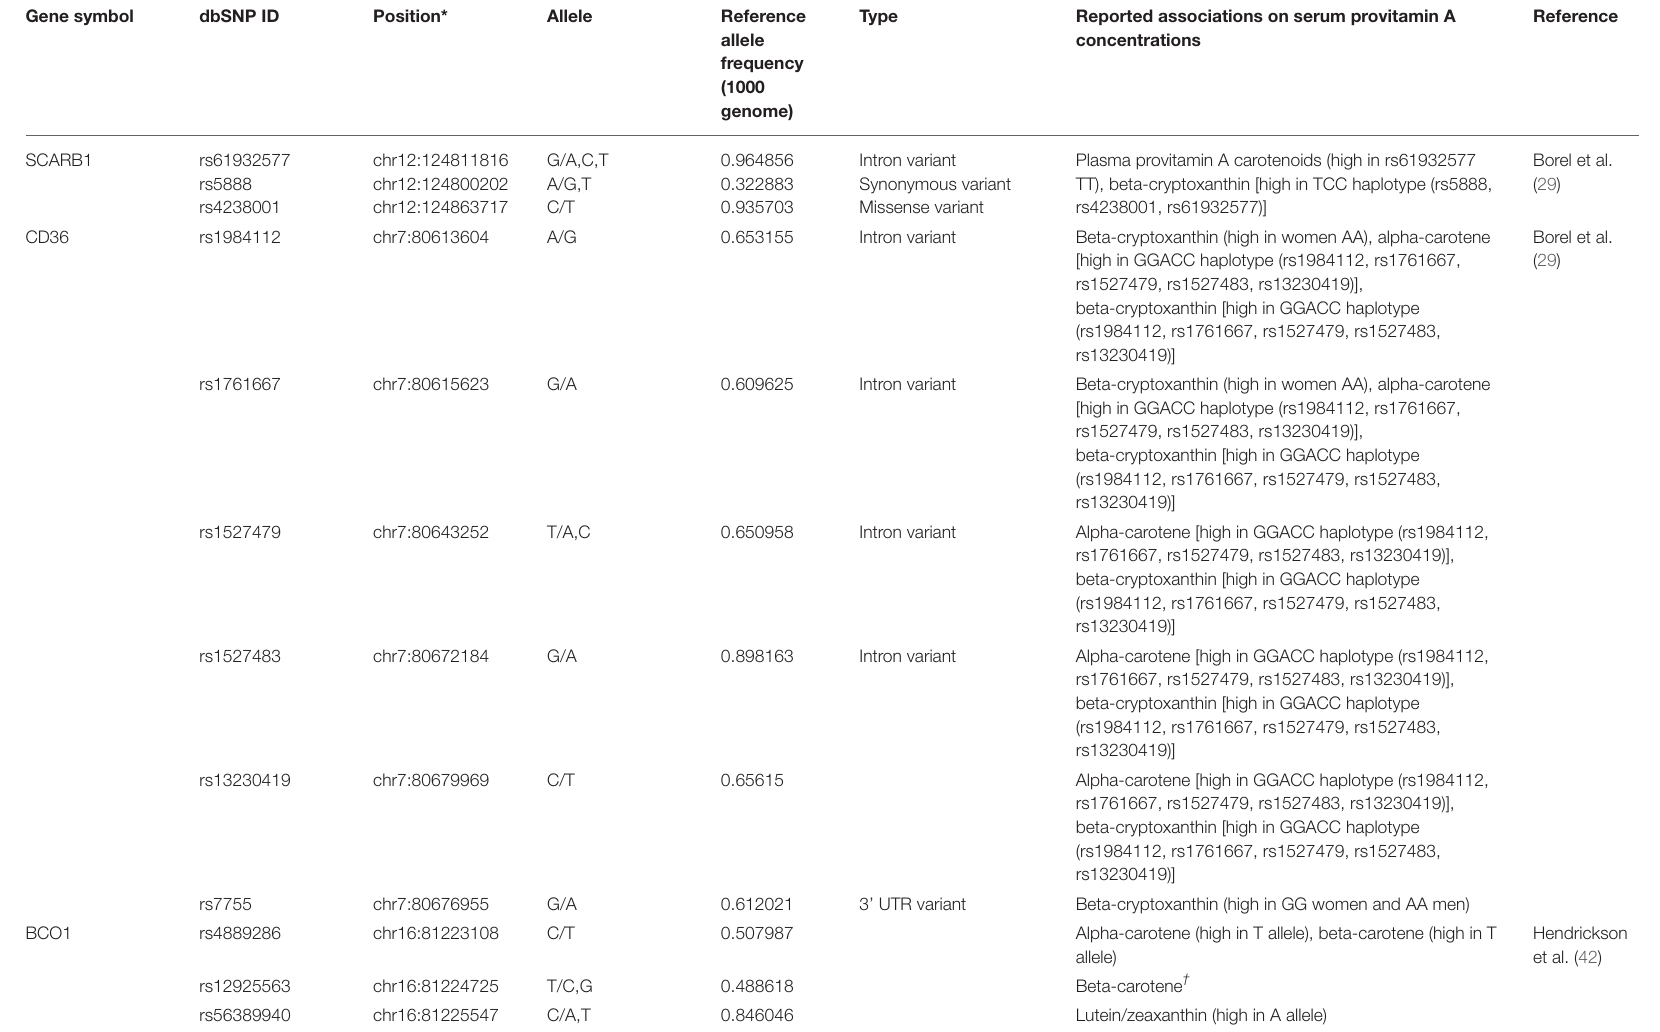
TABLE 1 | A list of sequence polymorphisms and the reported associations on provitamin A intestinal